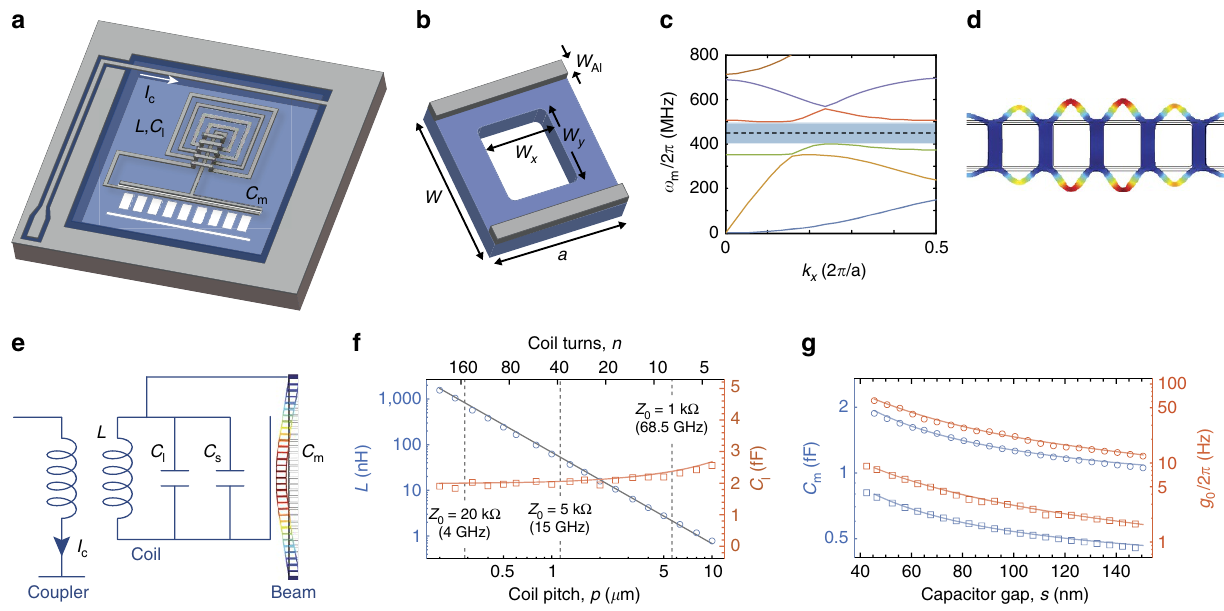
Figure 1 | Device design. ( a ) Schematic of the membrane electromechanical circuit. ( b ) Unit cell of the phononic crystal nanobeam. ( c ) Acoustic band diagram of the phononic crystal nanobeam with a ¼ W ¼ 2.23 m m, W x ¼ W y ¼ 1.52 m m and W Al ¼ 170nm. The nitride membrane thickness and aluminum wire thickness are t mem ¼ 300nm and t Al ¼ 65nm, respectively. The acoustic bandgap is shaded in blue, with the localized breathing mode frequency indicated as a dashed line. ( d ) Plot of the finite-element method (FEM)-simulated breathing mode profile. Mechanical motion is indicated by an exaggerated displacement of the beam structure and by colour, with red (blue) colour indicating regions of large (small) amplitude of the motion. ( e ) Electrical circuit diagram, where I c is the current through the reflective coupler, L is the coil inductance, C l is the coil capacitance, C s is additional stray capacitance and C m is the motional capacitance. The simulated displacement of the in-plane fundamental flexural mode of the beam is shown. ( f ) Inductance ( L ) and capacitance ( C l ) of a planar square coil inductor of constant area A coil ¼ 87 m m (cid:2) 87 m m and variable wire-to-wire pitch p . Wire width and thickness are 500 and 120nm, respectively. Method of moments 30 numerically simulated values are shown as open circles (inductance) and open squares (capacitance). Calculations using an analytical model of the planar coil inductor 31 are shown as a solid line. Vertical lines are shown for coils with a characteristic impedance of Z 0 ¼ 1, 5 and 20k O , with the coil self-resonance frequency indicated in brackets. ( g ) FEM simulations of the modulated capacitance C m (blue symbols) and the electromechanical coupling g 0 /2 p (red symbols) of the in-plane fundamental flexural mode (circles) and the phononic crystal breathing mode (squares) as a function of the capacitor gap size s . Solid curves indicate a 1/ s fit for C m and 1/ s d with d E 1.4 for g 0